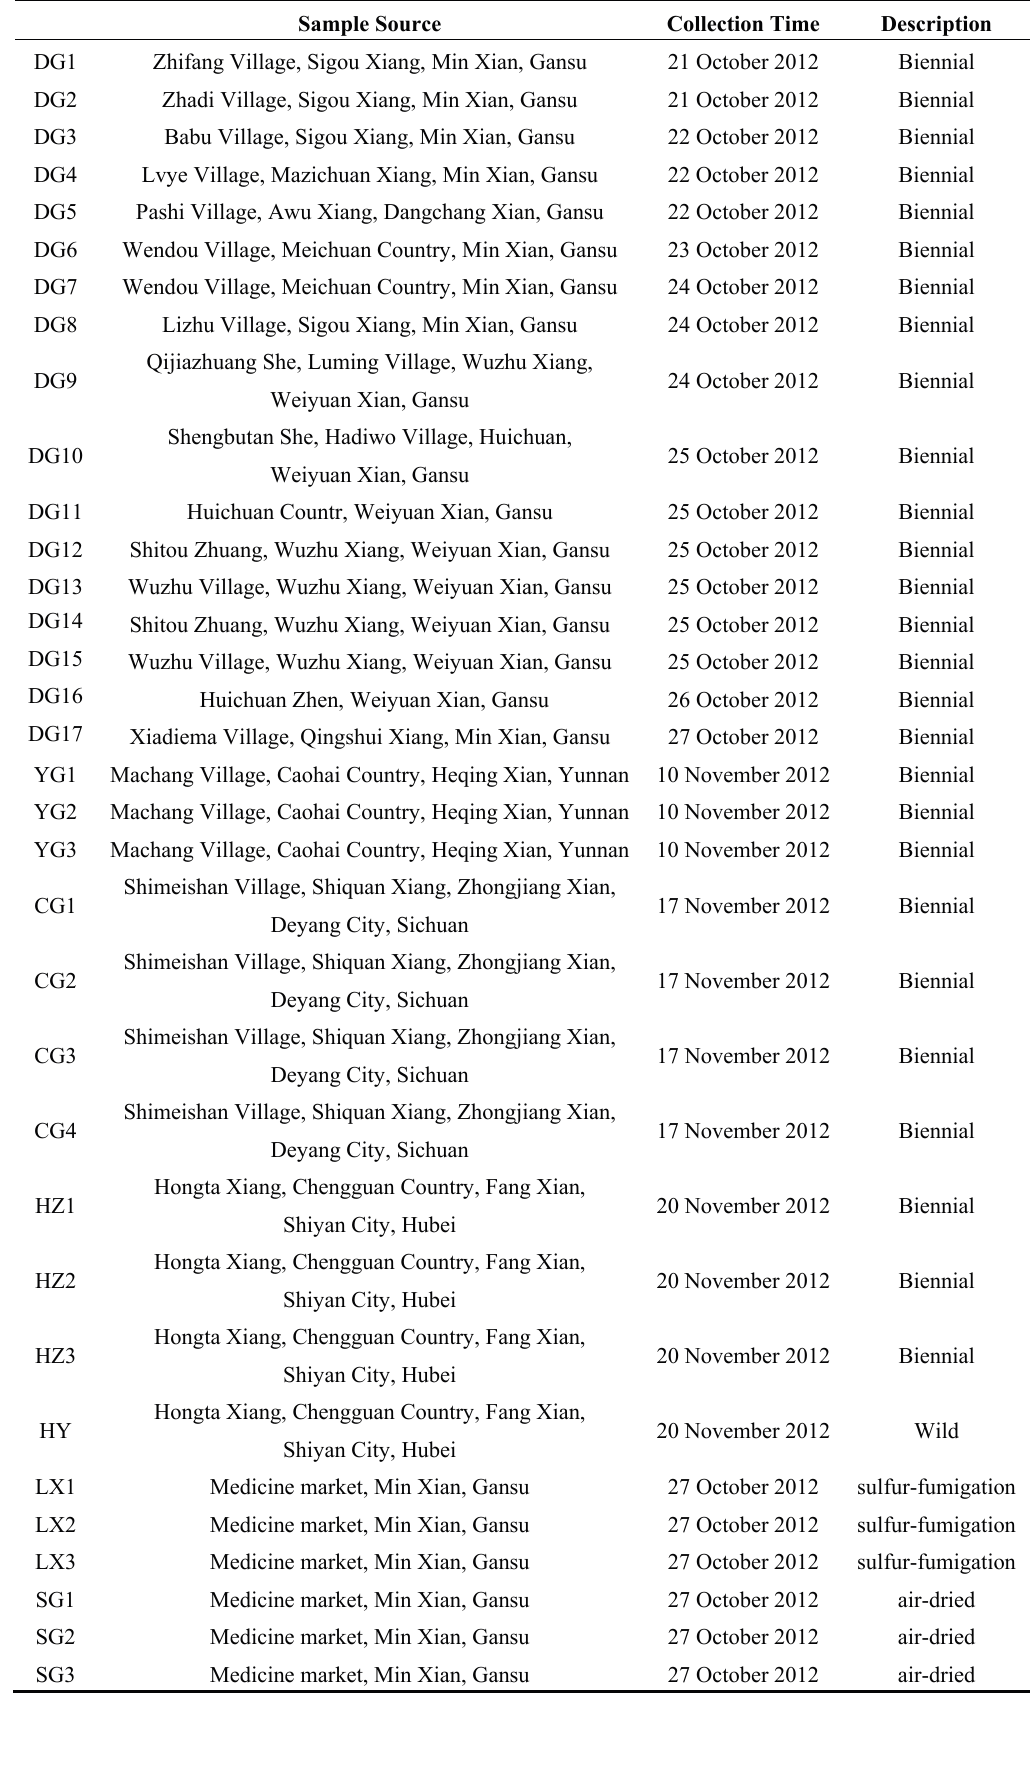
Table 3. Angelica sinensis used in the experiments. Sample Source Collection Time